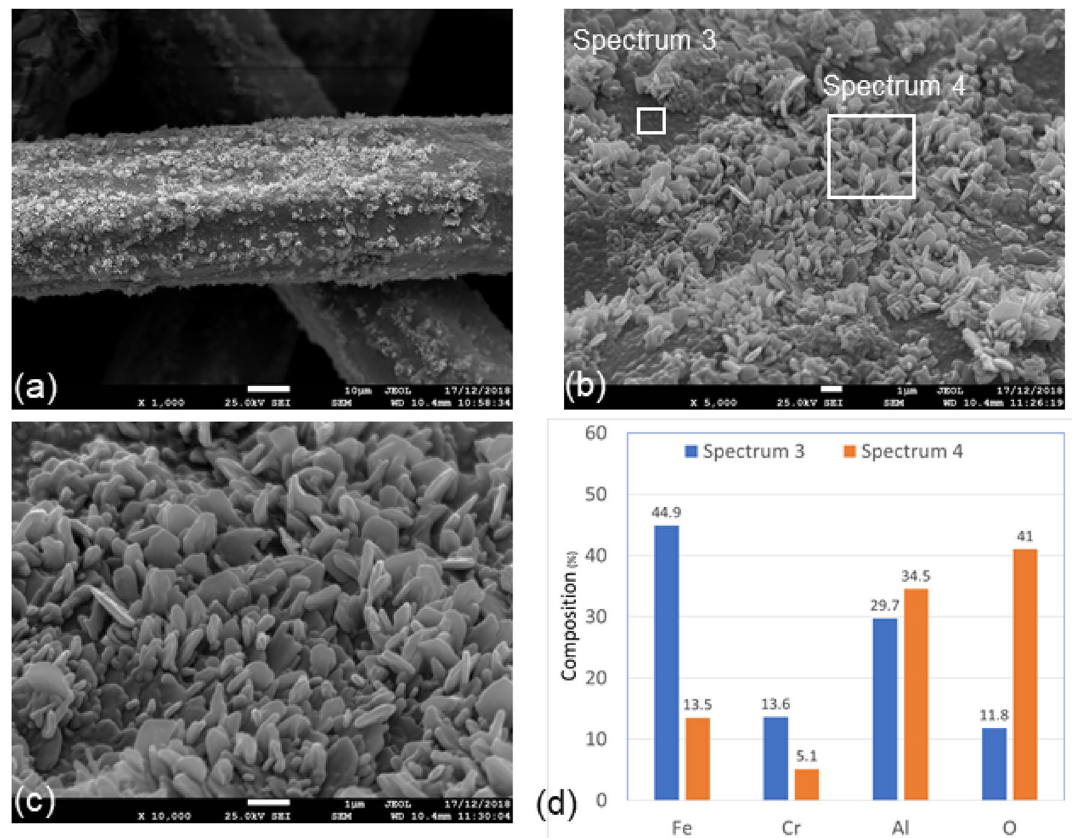
Figure 7. SEM micrograph images and EDS analysis of Sample 2, after one MSHT cycle, FeCrAl fibers at different magnifications, ( a ) × 1000; ( b ) × 5000; ( c ) × 10,000; ( d ) EDS scans of Spectrum 3 and Spectrum